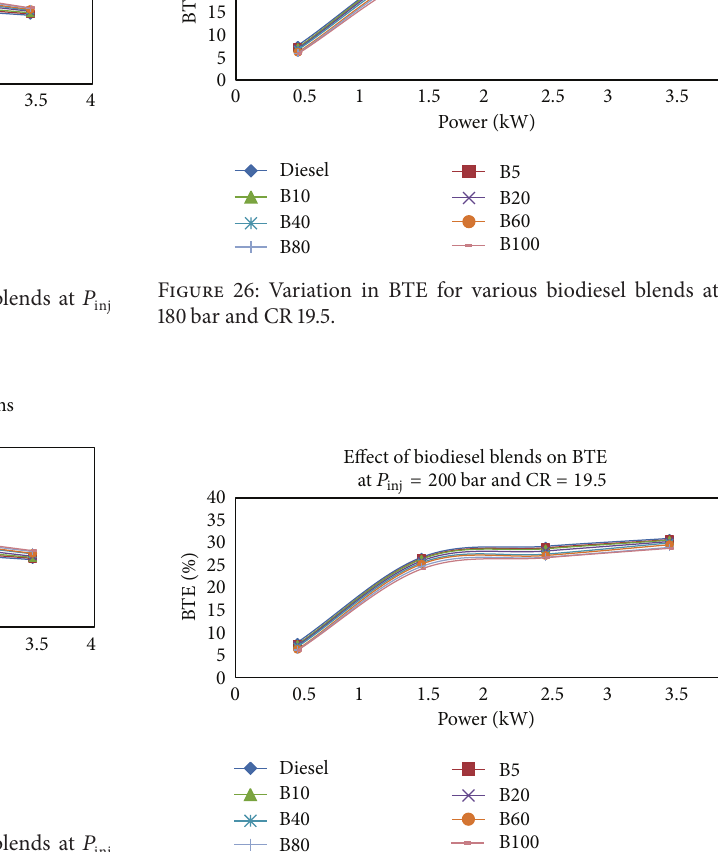
inj Figure 27: Variation in BTE for various biodiesel blends at 𝑃 200 bar and CR 19.5.